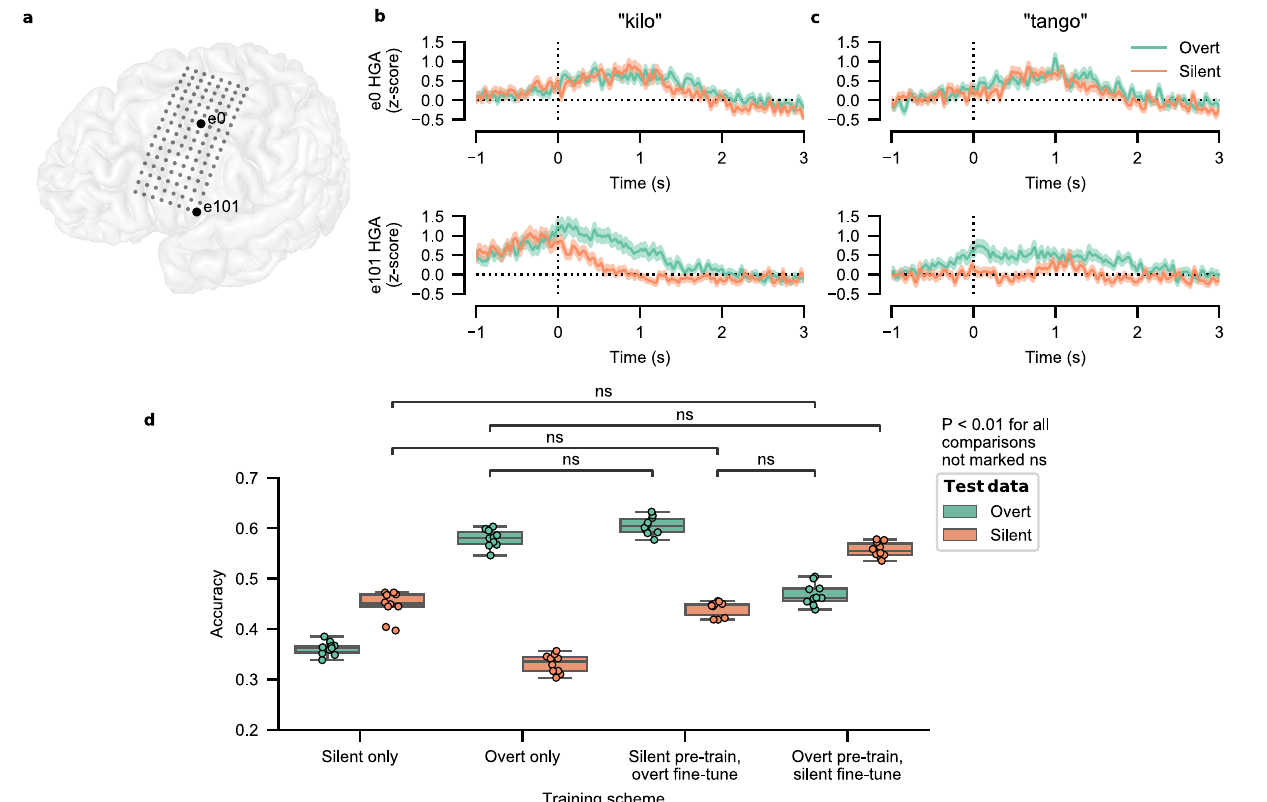
Fig. 5 | Differences in neural signals and classi fi cation performance between overt-andsilent-speechattempts.a MRIreconstructionoftheparticipant ’ sbrain overlaidwithimplantedelectrodelocations.Thelocationsoftheelectrodesusedin b and c are bolded and numbered in the overlay. b Evoked high-gamma activity (HGA) during silent (orange) and overt (green) attempts to say the NATO code word kilo. c Evoked high-gamma activity (HGA) during silent (orange) and overt (green) attempts to say the NATO code word tango. Evoked responses in b and c arealignedtothegocue,whichismarkedasaverticaldashedlineattime0.Each curve depicts the mean±standard error across n =100 speech attempts. d Code-